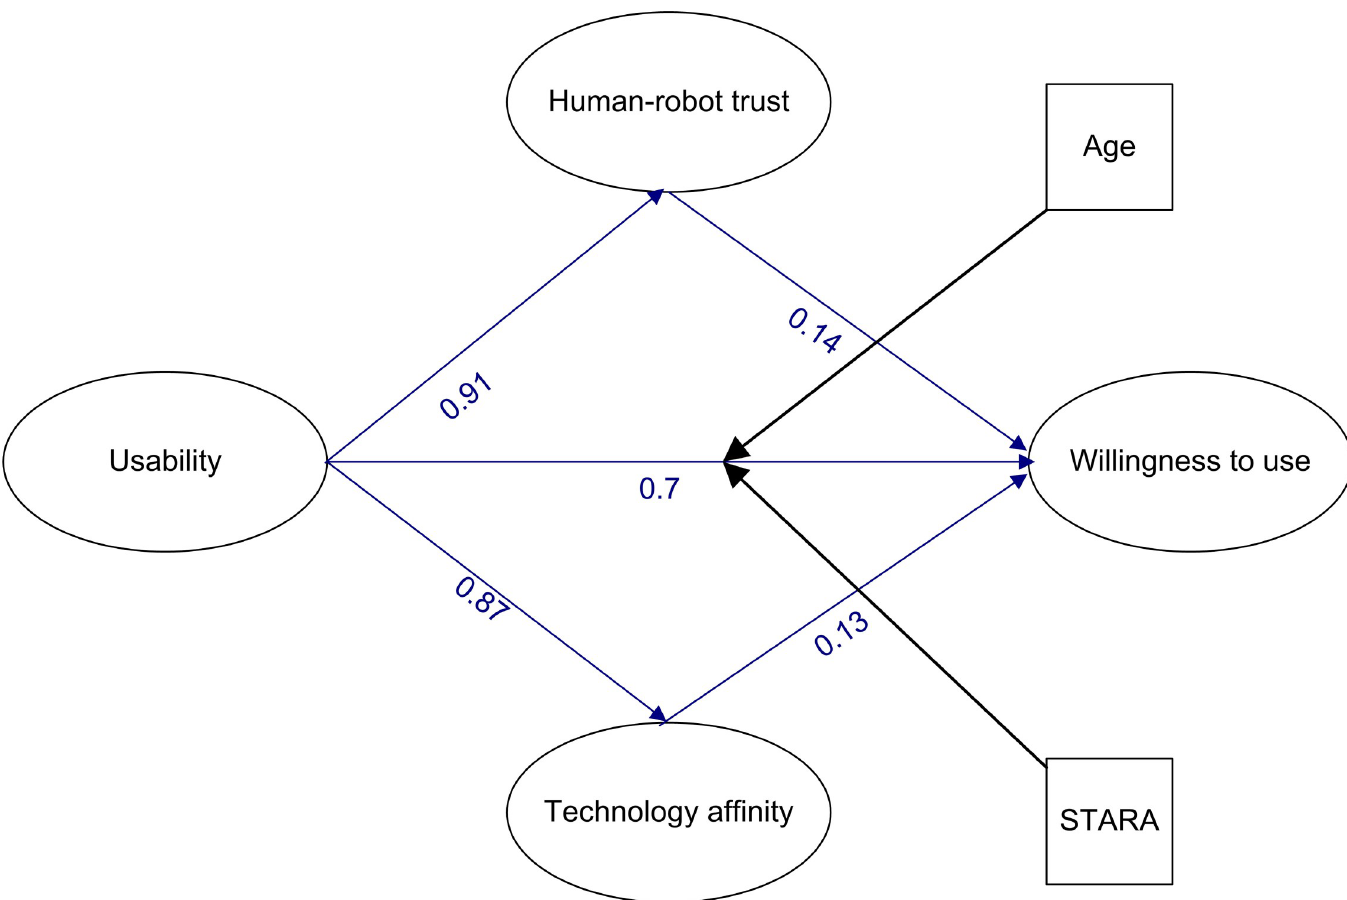
� : 4.72; GFI: 0.57; AGFI: 0.53; IFI: 0.80; TLI: 0.79; CFI: df